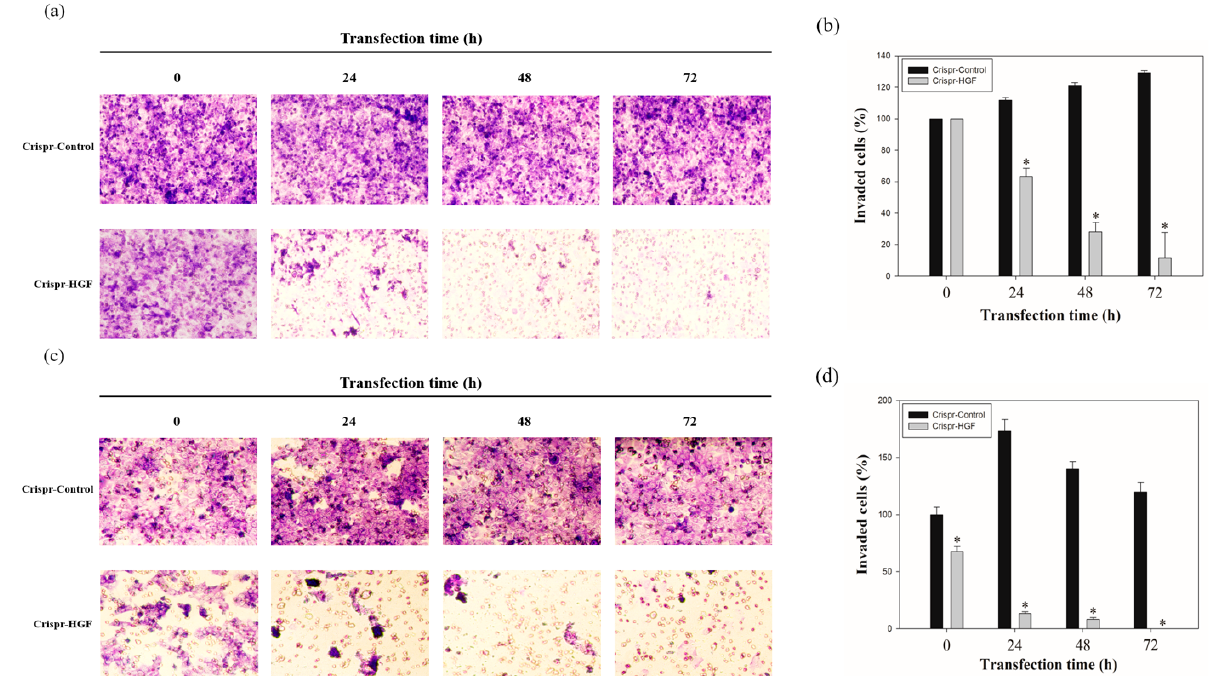
Figure 6. Invasion ability of ( a ) Huh7 and ( c ) Hep3B cells transfected with Crispr-Control and Crispr-HGF. Invaded cells were increased in Crispr-Control-transfected group, however, that of Crispr-HGF-transfected group were decreased. ( b , d ) The bar graph indicates that invaded cells were decreased in Crispr-HGF-transfected Huh7 cells. Error bar represents the mean ±SEM. * p < 0.05. These assays were performed at least three times in triplicate.